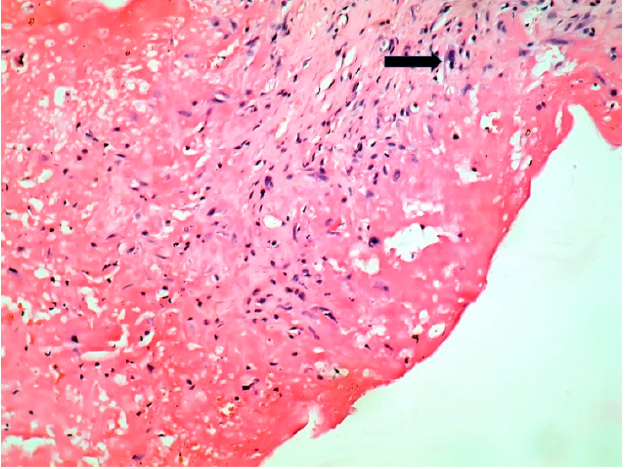
Figure 4. Tricuspid valve endocarditis; a multinucleated cell (arrow) within the mild inflammation at the vegetation base (arrow) (HE stain × 10).